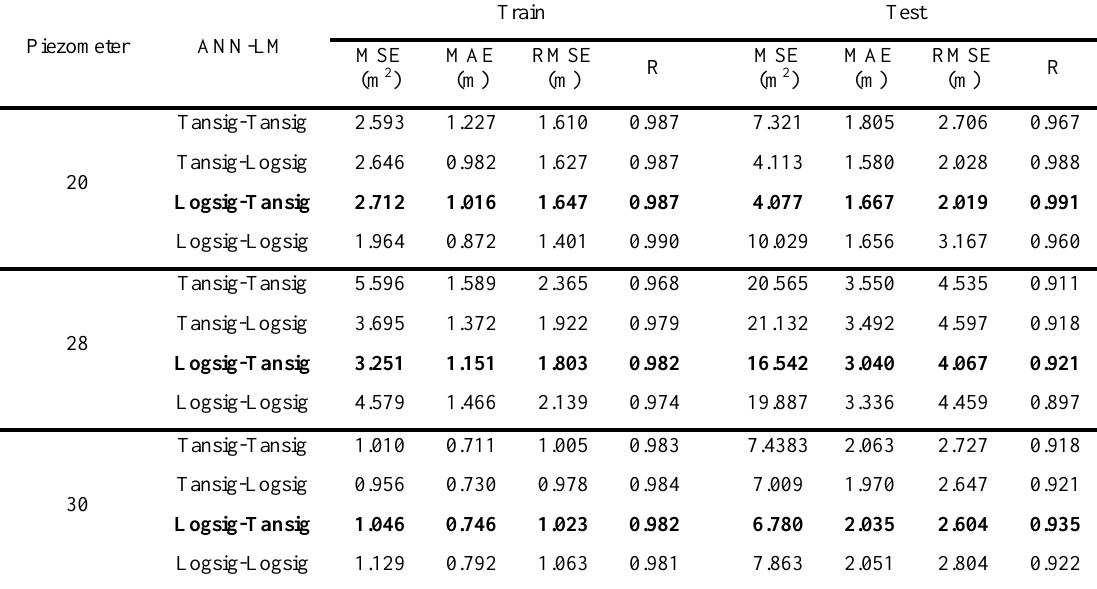
Table 3- Results of modelling ANN-LM in order to simulate water level variations of piezometers of Jiroft Dam Piezometer ANN-LM